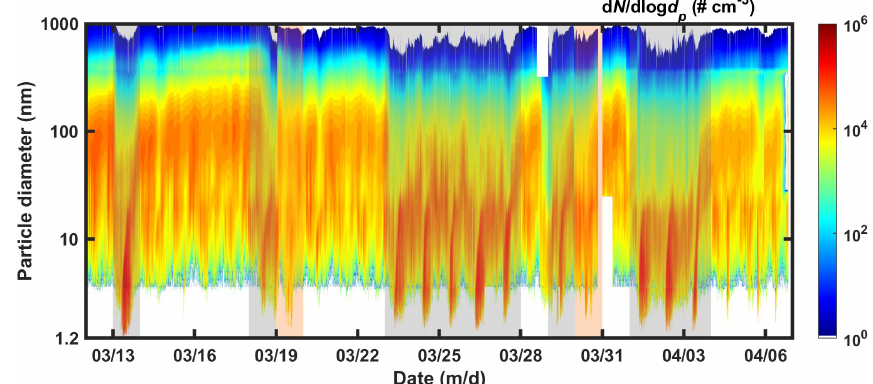
Figure 1. Contour of measured particle size distributions from 12 March to 6 April 2016. The identified 11 NPF days and 2 undefined days are shaded with a grey and orange background, respectively.